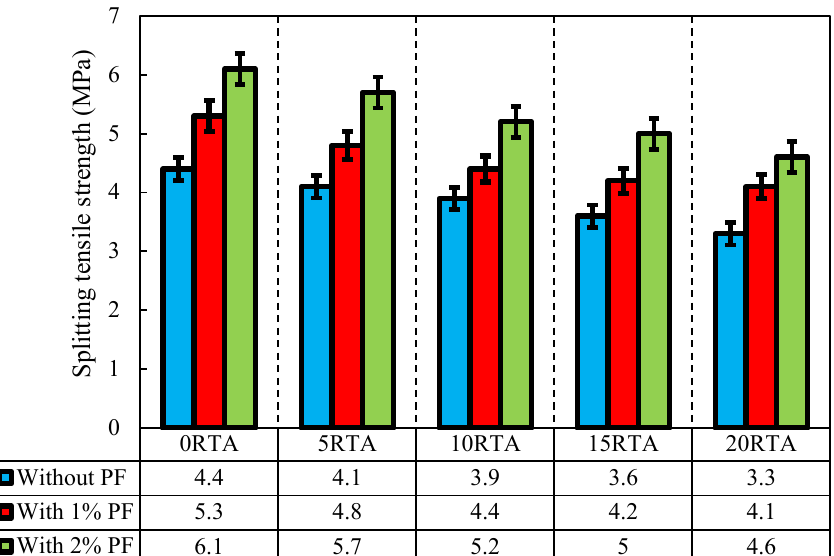
Figure 5. Impact of PF and RTA on the tensile resistance.